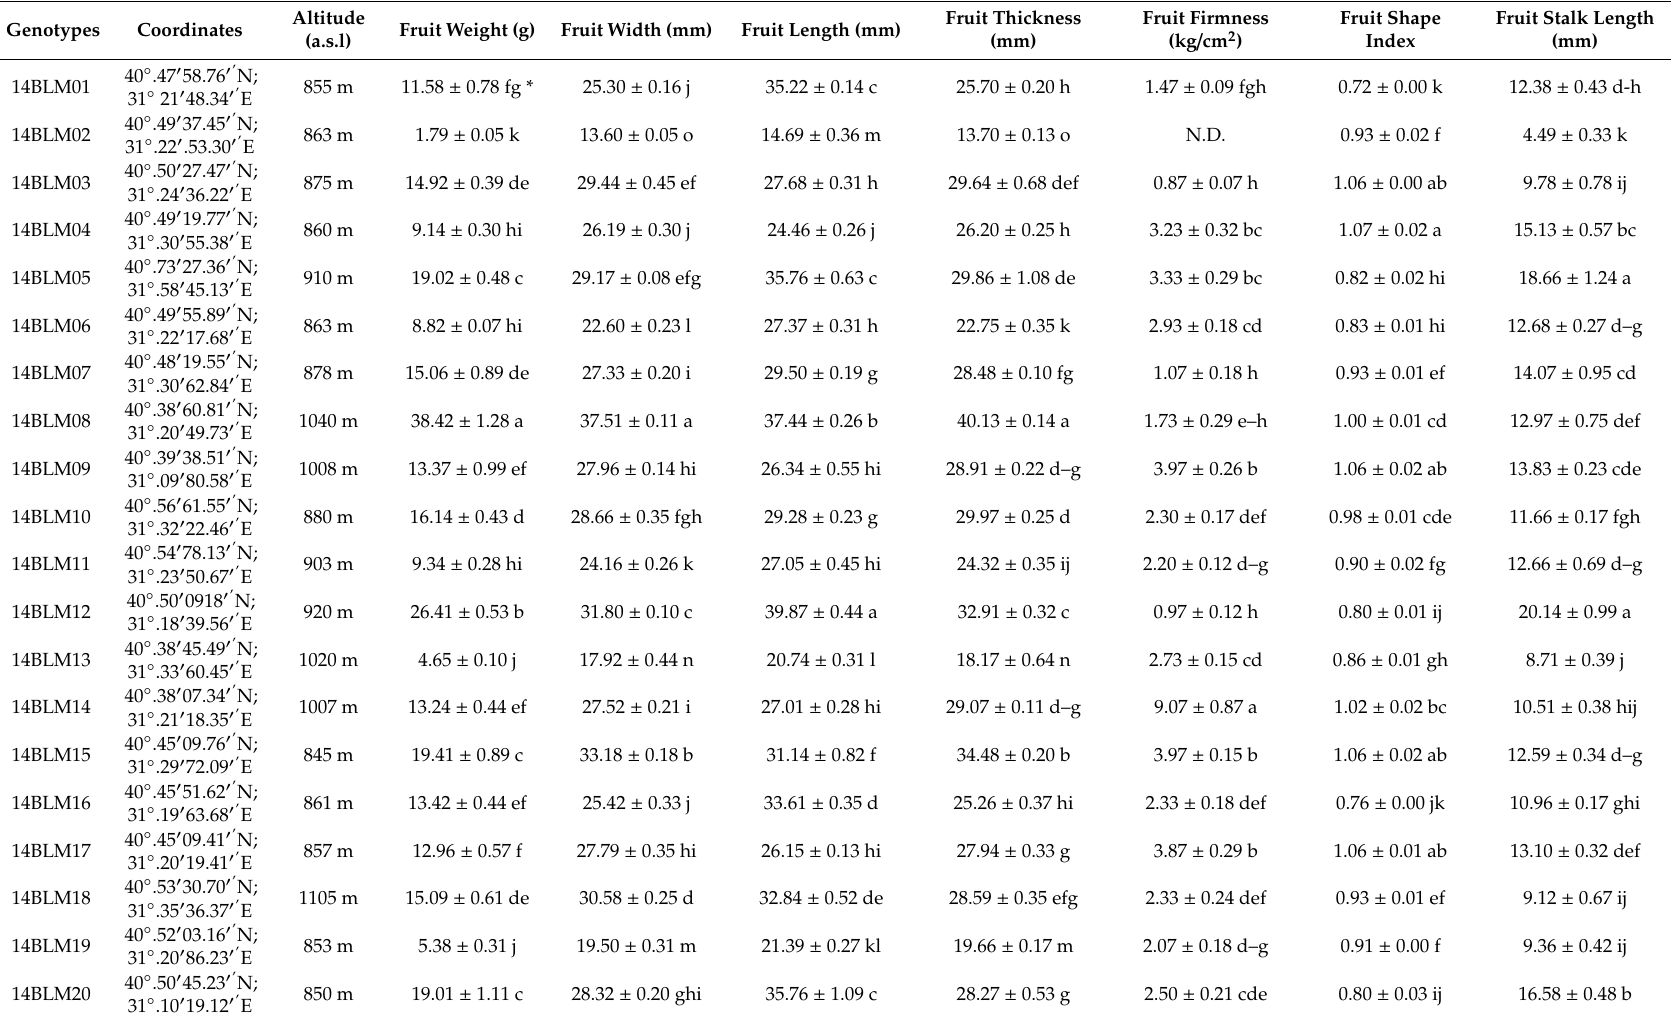
Table 1. Some agro-morphological fruit properties of plum